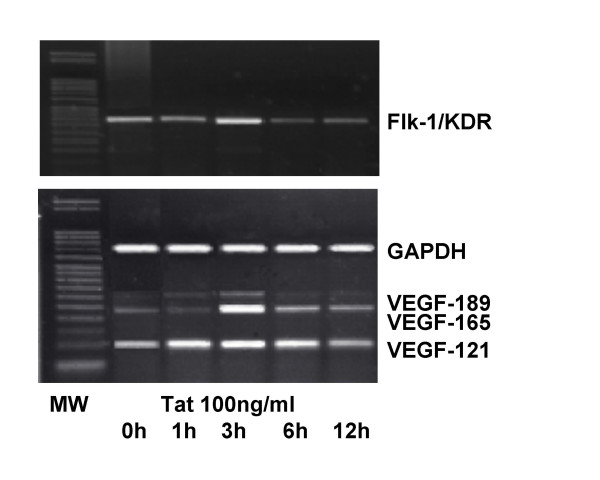
Semiquantitative RT-PCR of VEGF family genes in MCF-7 cells cultured in low-serum medium and exposed for different times to extracellular Tat86aa. Increased expression of the VEGF receptor-2 (Flk-1/KDR) and VEGF isoform 165. To a lower extent, the VEGF isoform-121 was also up-regulated. The GAPDH signal was used as a control. MW, DNA molecular weight ladder.